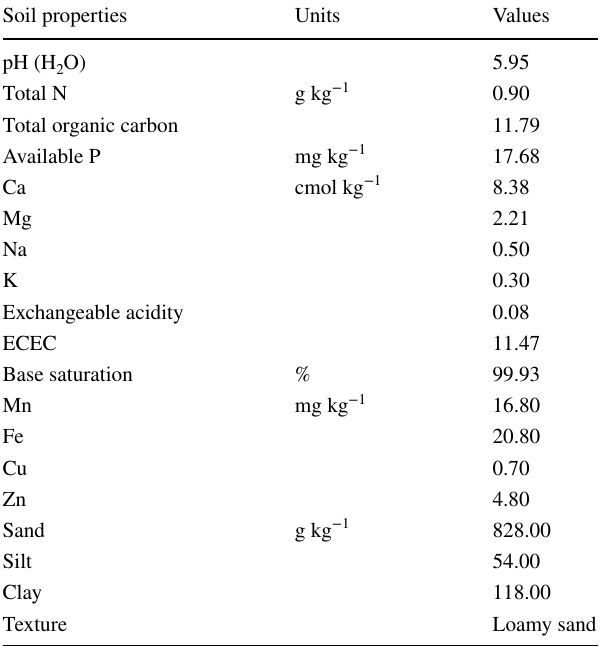
Table 2 Physicochemical soil properties of the experimental site Soil properties